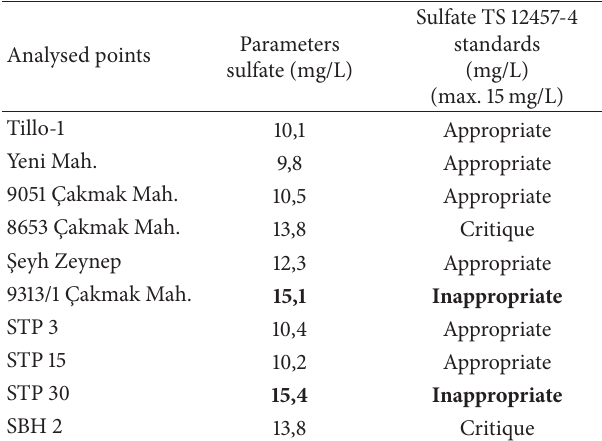
Table 3: Comparison of sulfate